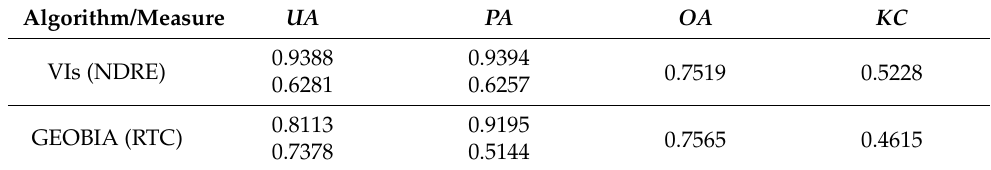
Figure 15. ROC curves and AUC values for RT and FT polygons comparison. Table 3. Accuracy assessment results for RT and FT polygons comparison.